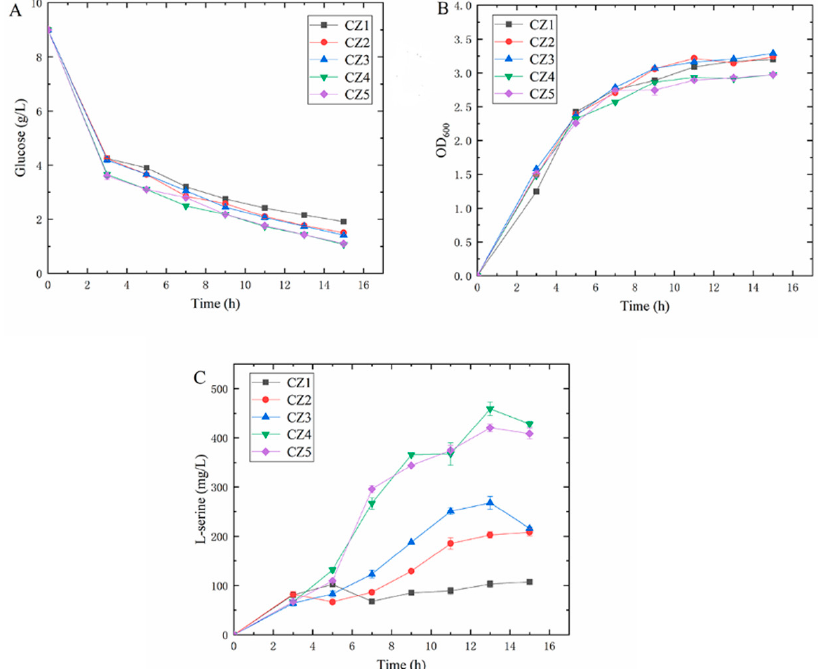
Figure 1. Experimental results of shake flask fermentation with different carbon–nitrogen